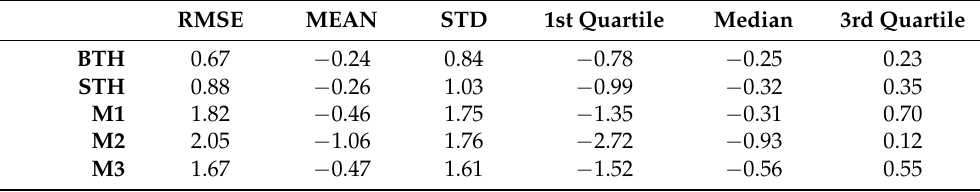
Table 5. Main statistics for the entire period (determined against the radiosondes (RS)